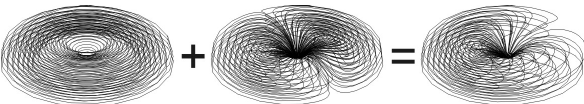
Fig. 2. Electric current flow lines, corresponding to the sym- Fig.2. Electriccurrentflowlines,correspondingtothesymmetric(left)and‘quadrupole’(centre)components metric (left) and “quadrupole” (centre) components of the model ofthemodelPRC,andtheresultanttotalconfiguration(right),calculatedfromEqs. (8)–(11). PRC, and the resultant total configuration (right), calculated from dipolar background magnetic field B o , which eliminated the need to numerically trace the field Eqs. lines in the calculation of the electric currents from Eqs.(8–11). In addition, the axial symmetry of